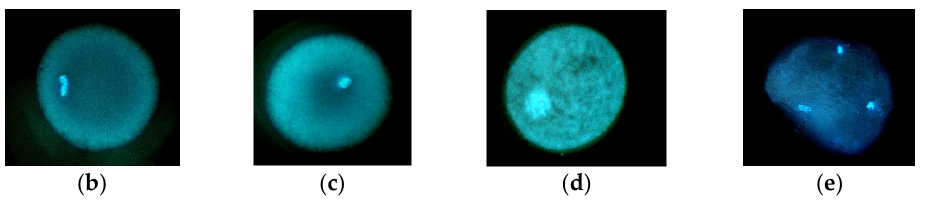
Figure 1. Nuclear status of bovine oocytes. Stained with Hoechst 33,342: ( a ) M ‐ II, ( b ) T ‐ I, ( c ) M ‐ I, ( d ) GVBD, and ( e ) DG (400×).